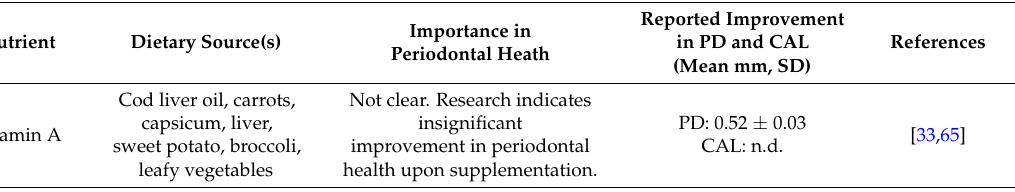
Table 1. Major vitamins, their dietary sources, daily requirements, deficiency diseases, and reported importance in periodontal